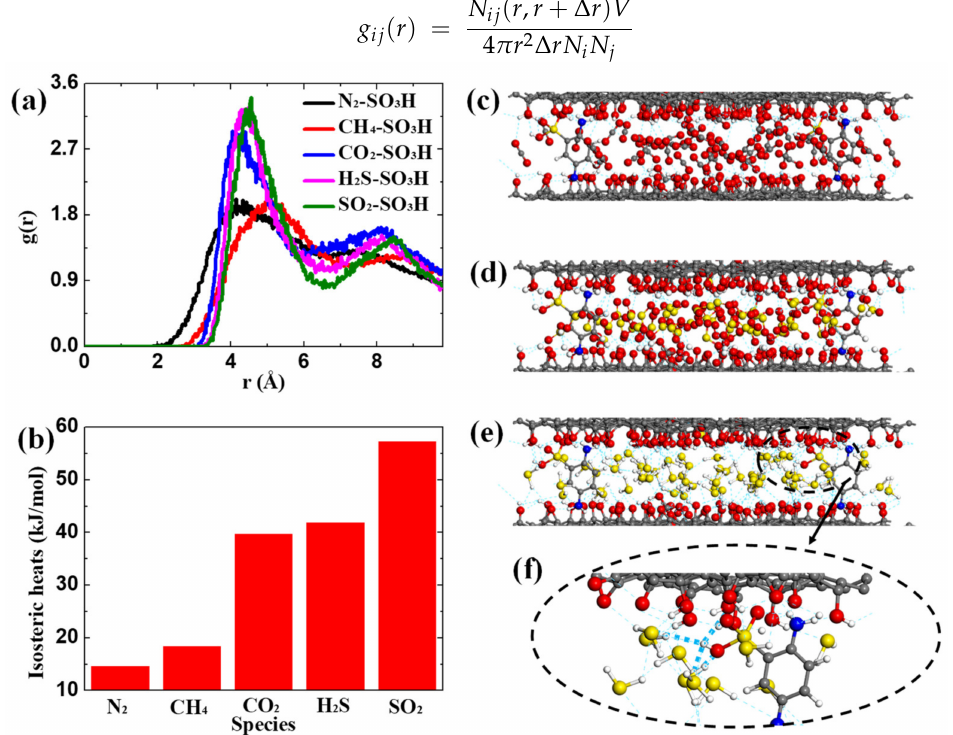
Figure 4. Adsorption Insights. ( a ) RDF of the doped PDASA to various gases. ( b ) Isosteric heats. Hy- drogen bonds formed in the adsorption process of acid gases. ( c ) CO 2 . ( d ) SO 2 . ( e ) H 2 S. ( f ) Hydrogen bonds around